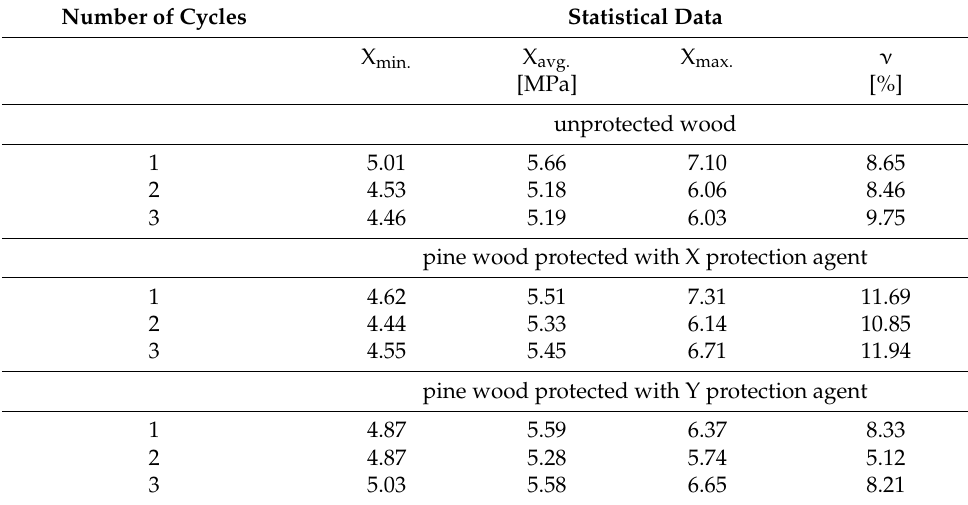
Table 7. Results of aging tests of glue lines from pine wood joints after D11 aging tests acc. to the PN-EN ISO 9142 standard